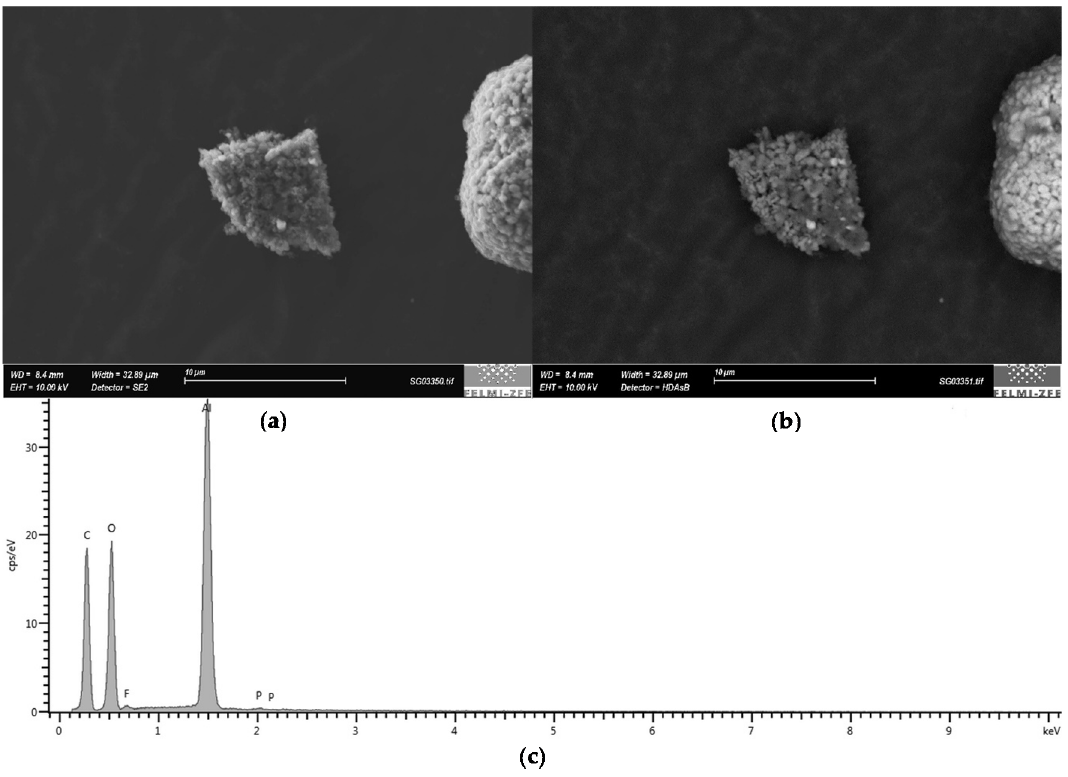
Figure 13. Analysis of a particle of class 1: ( a ) SE image, ( b ) BSE image, ( c ) EDX spectrum. The presented scale in ( a ) and ( b ) is 10 µm.